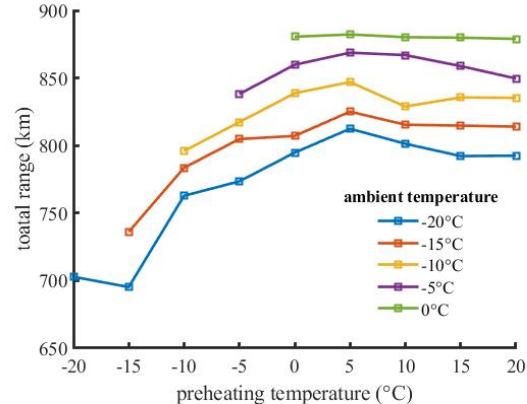
Figure 10. Simulation results under the NEDC driving condition.